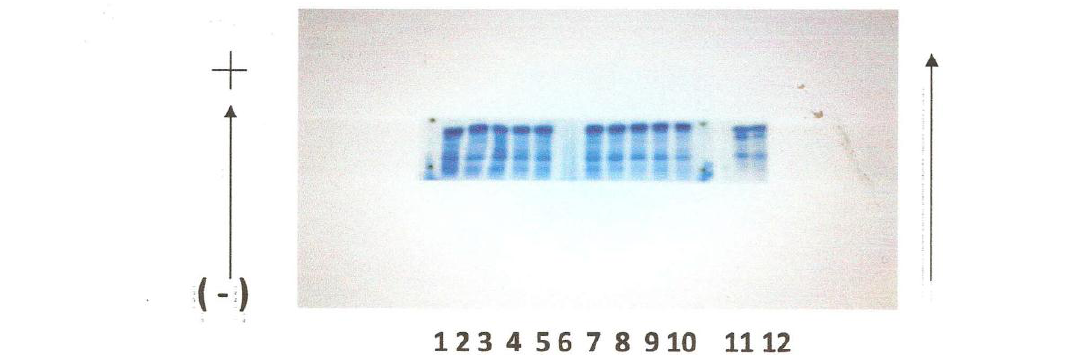
Figure (B) :- Agarose Gel Electrophoresis of blood serum at PH 8.6, size of sample 5µl. 1, 2, 3:- Rats received 1% H2O2 + polyphenolic compounds of olive (200mg/kg) orally for 30 days 4, 5,6:-Rats received polyphenolic compounds of olive (200mg/kg) orally for 30 days . 7, 8, 9 :- Rats received tap water.10, 11,12:- Rats received 1% H2O2 in drinking water .